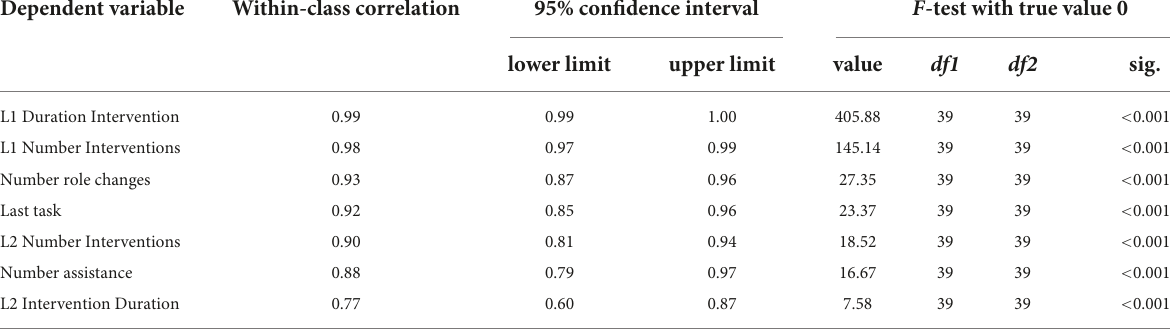
TABLE 3 Intraclass correlation